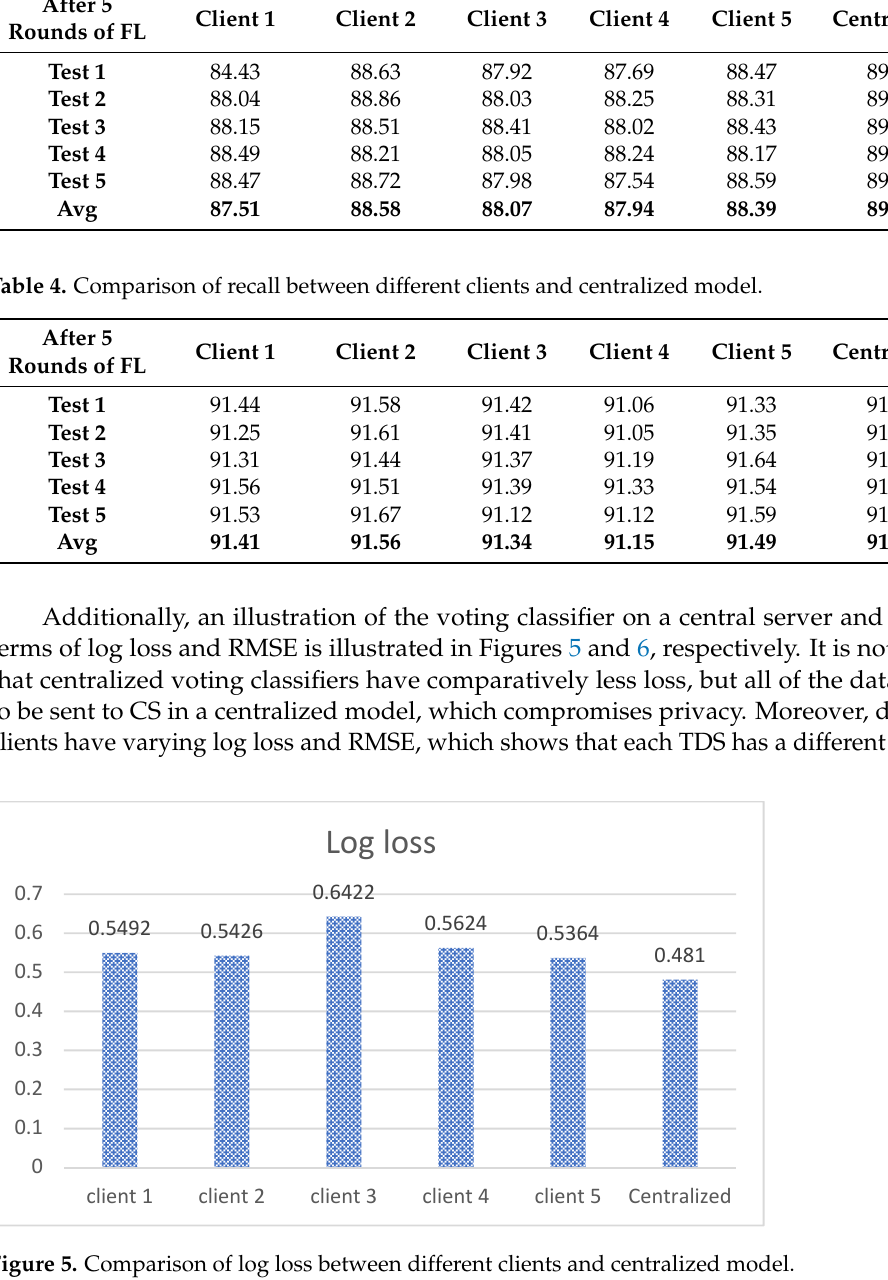
Figure 6. Comparison of average RMSE between different clients and centralized model. 5.2. Comparison with Other State-of-the-Art Models Finally, the comparison of previous state-of-the-art models is given in this section. The accuracy, precision, F-measure, and recall findings are expressed in Table 5, whereas Figures 7 and 8 illustrate the log loss and RMSE. Two federated clients (i.e., TDSs) and one federated round are considered for these experiments. The neural networks used in this research in a federated manner are simple recurrent neural networks (RNN), simple long-short term memory (LSTM), and simple gated recurrent units (GRU). Each model used one input layer, one RNN/LSTM/GRU layer with 64 neurons and “ tanh ” as an acti- vation function. These neural networks also have one output layer with “sigmoid” as an activation function. Moreover, results of FVC are also compared with the previous litera- ture; specifically, FedCNN was proffered by Chen et al. [18] for abnormal detection in wearable health, FedMLP was presented by Schneble et al. [31] for identification of abnor- malities in computer programs, and FedTCN was used by Wen et al. [19] for energy theft detection. It can be seen from Table 4 that the accuracy, precision, and F-measure of FVC are the highest among all the models. In addition, Figures 7 and 8 illustrate that the pro- posed FVC approach has the lowest log loss and RMSE. Table 5. Comparison of previous literature with FVC in terms of accuracy, precision, F-measure, and recall. Models